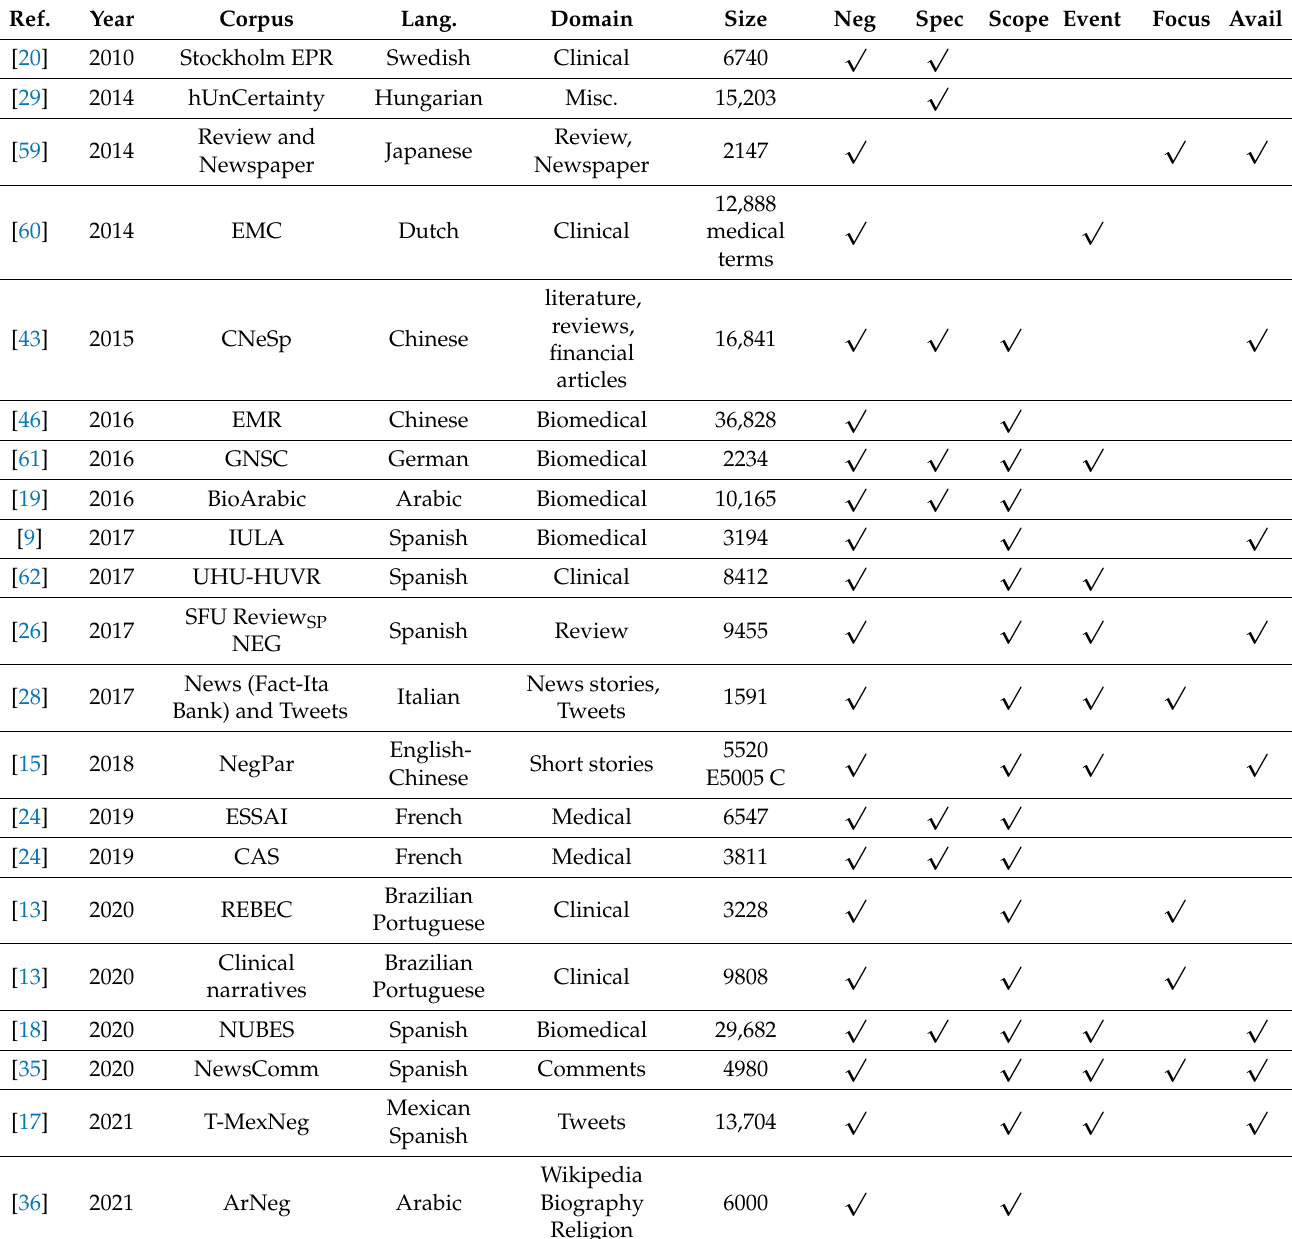
Table 2. Non-English corpora annotated with negation and/or speculation.